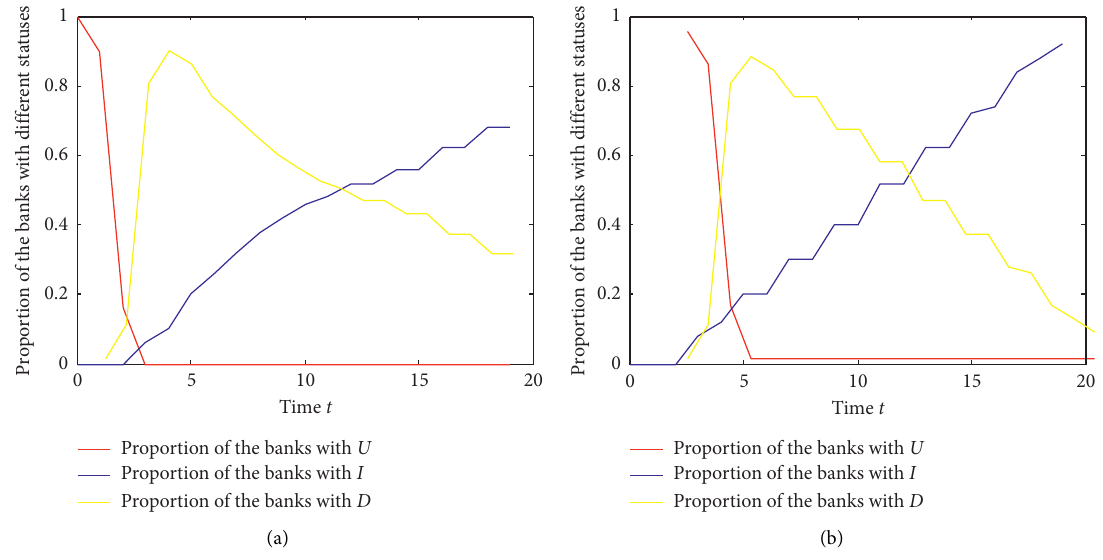
Figure 5: Changes of proportion of banks’ status over time under different external shock